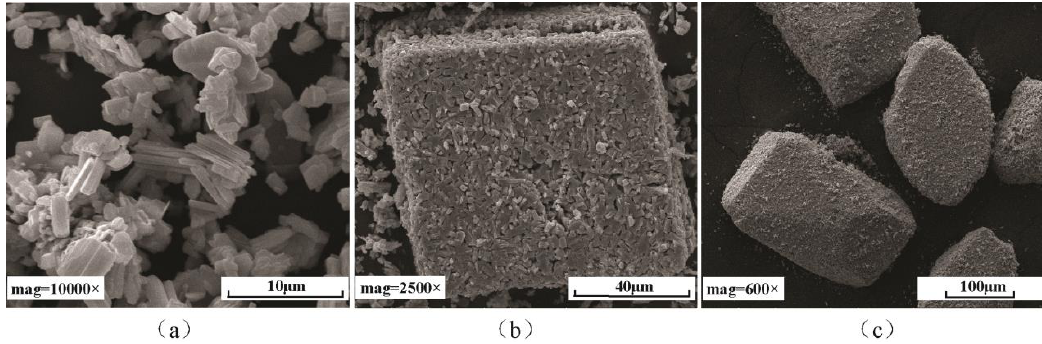
12 of 17 Figure 14. Wear scar images and 2D profile curves of samples lubricated with ( a ) base oil and ( b ) base oil with 0.5 wt % MoO 3 at 150 °C. 3.5. Influence of the Particle Sizes